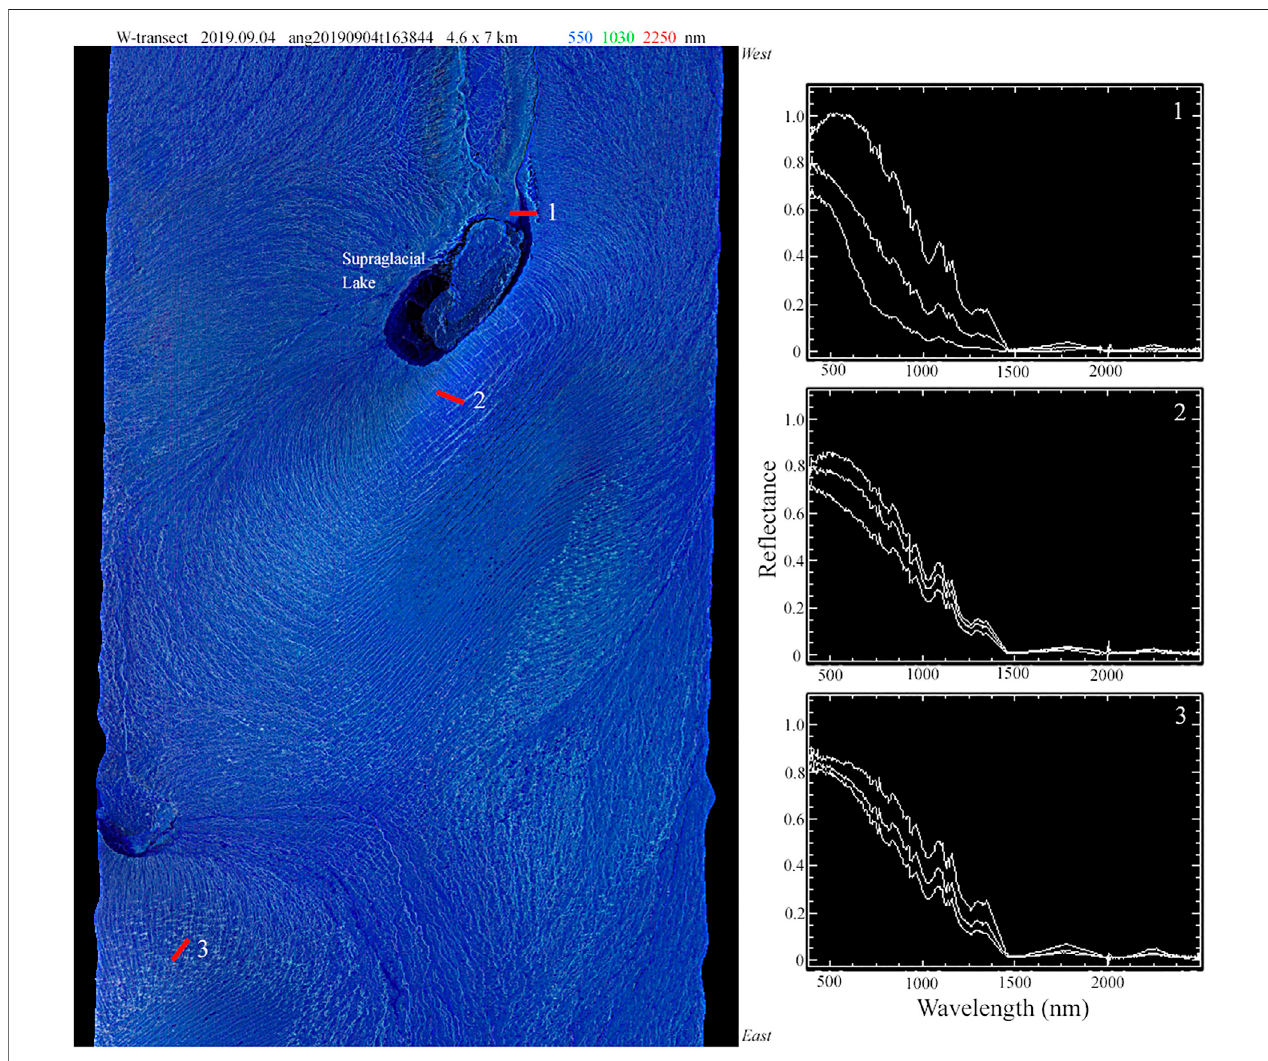
FIGURE 11 | Full resolution AVIRIS-NG swath and spectra from W-transect. Variations in re fl ectance and illumination geometry reveal crevasse texture. Example spectrafromadjacent,ornear-adjacent,pixelsshowmetertodecameterscalevariationsin fi rnandicere fl ectancethatwouldcontributetothespectralmixingoccurring within decameter satellite imagery. Ground sample distance is 6.8